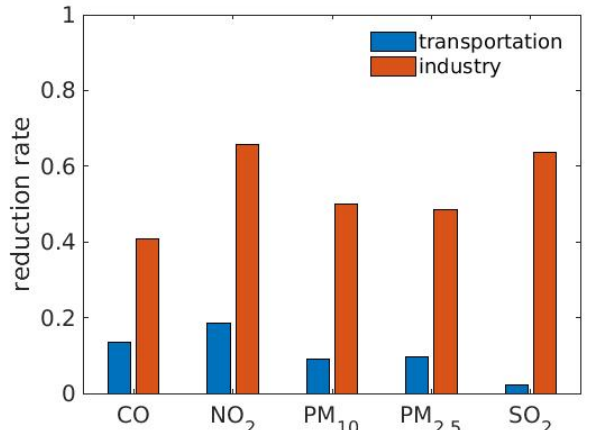
Figure 8. The reduction rate of pollutant concentrations due to the subtraction of transportation and industry emissions. Blue columns refer to the reduced pollution by removing all the transportation emission. Red columns refer to the reduced pollution by removing all the industry emission.